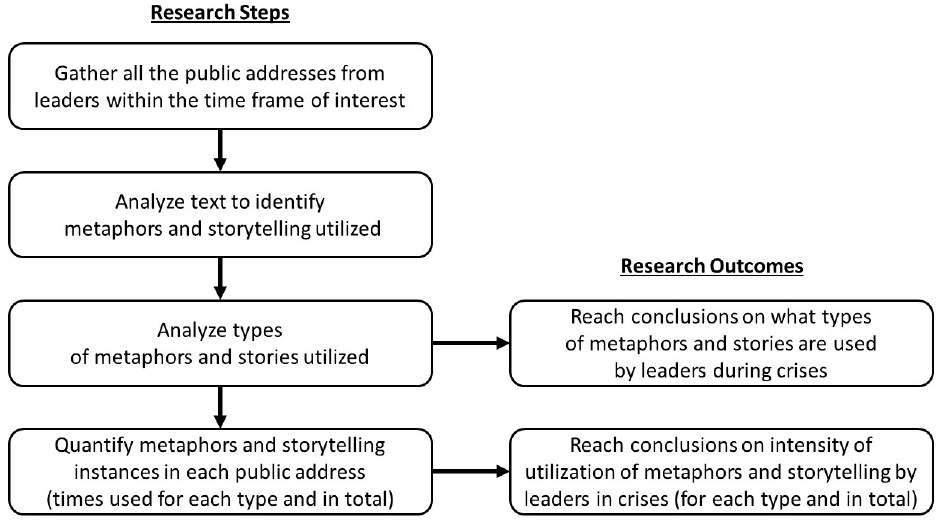
Figure 3. Research Outline: Data collection and analysis strategy employed.